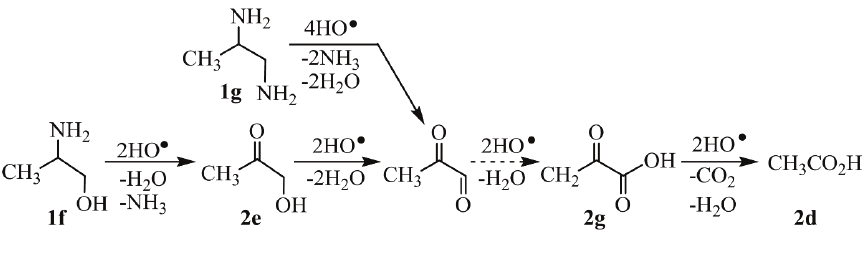
Figure 7. Degradation of 1h – m (Group C) by HO •